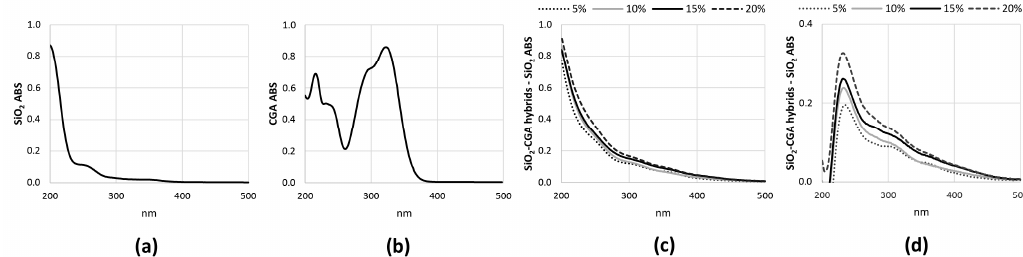
Figure 3. UV-VIS spectra of ( a ) pure SiO 2 ; ( b ) pure CGA; ( c ) SiO 2 /CGA hybrids. Panel ( d ) shows different UV-VIS spectra obtained by importing the acquired data into Excel and subtracting SiO 2 signals from the SiO 2 scan to those of each hybrid.